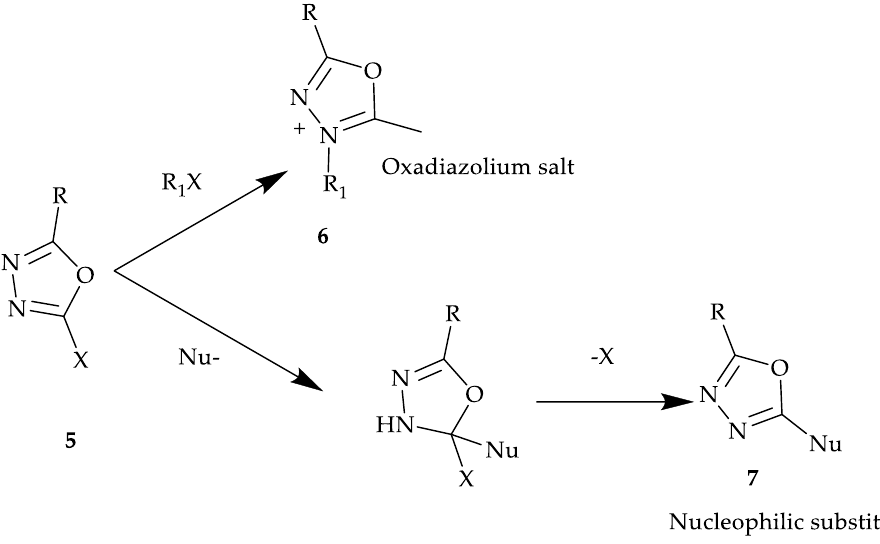
Figure 5. Nucleophilic